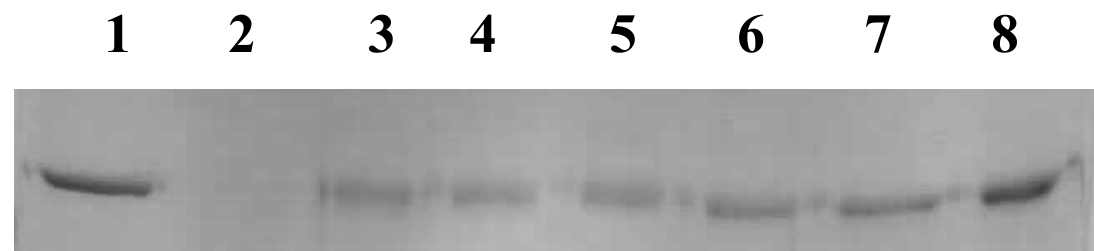
Figure 4. Inhibition of protein oxidation by NJE. Lane 1, BSA; Lane 2, BSA + AAPH; Lane 3,